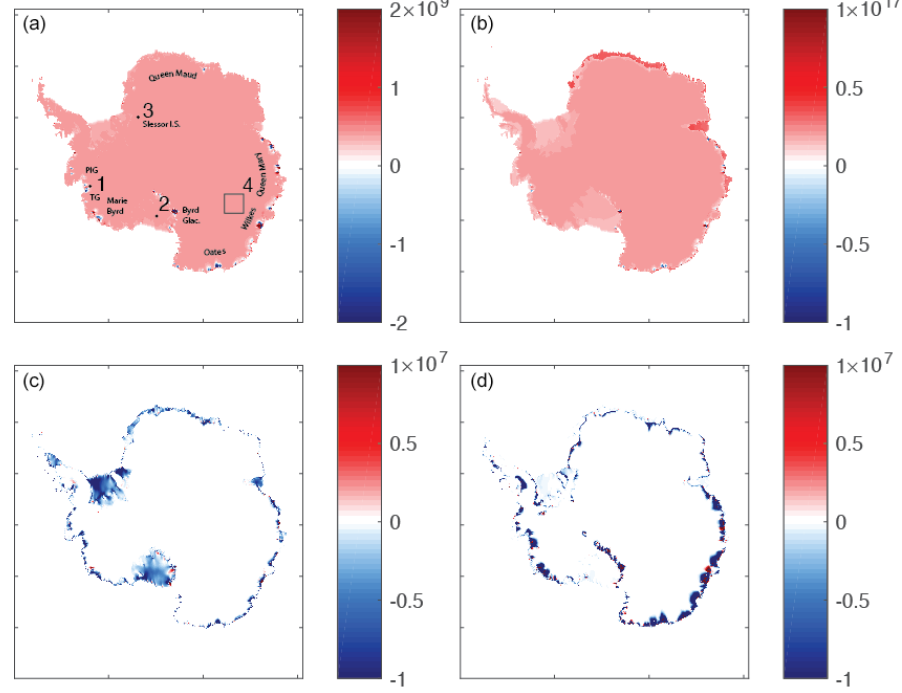
Figure 2. Adjoint sensitivities, δJ , for the Antarctic Ice Sheet, where X i is the control variable shown. Control variables are the (a) initial ice δX i thickness (m 2 ), (b) mean January precipitation (m 2 yr), (c) surface temperature (m 3 ◦ C − 1 ), and (d) basal temperature (m 3 ◦ C − 1 ). Locations in (a) numbered 1–4 are compared to finite-difference values in Table